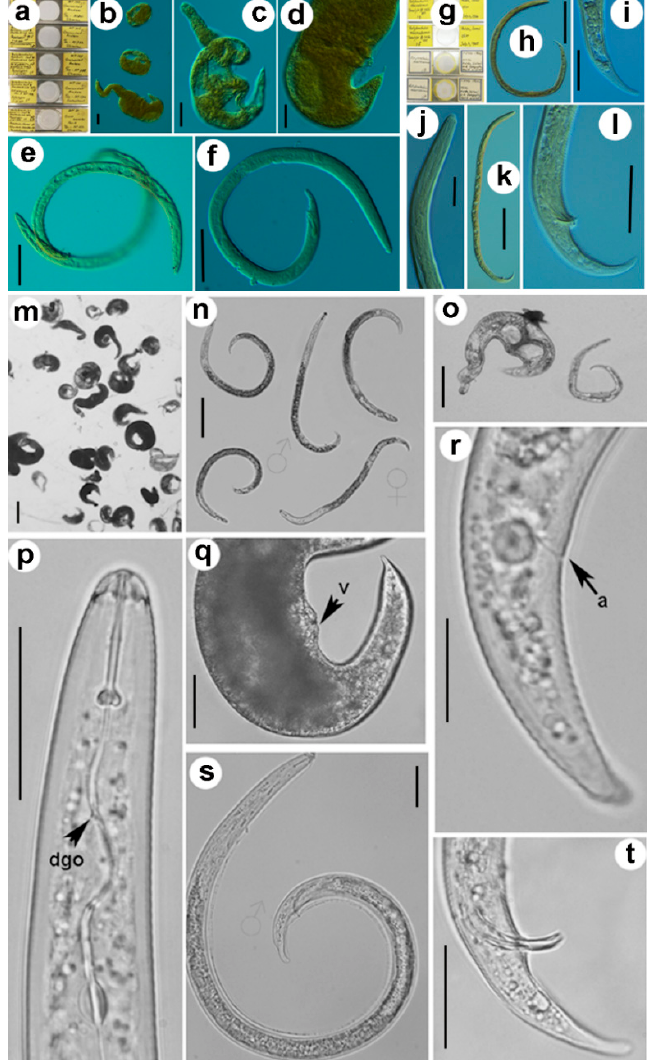
Figure 1. Comparative morphology among paratype specimens of Rotylenchulus borealis from the Netherlands ( a – f ), paratype specimens of Rotylenchulus macrosoma from Israel ( g – l ), and a population of Rotylenchulus macrosoma from Hungary ( m – t ). ( a , g ) slides deposited in Wageningen Nematode Collection (WANECO) and United States Department of Agriculture (USDA) nematode collections; ( b – d , m , o , q ) mature females; ( e , h – j , n , p , r ) immature females; ( f , k , l , n , s , t ) = males. Abbreviations: a = anus; dgo = dorsal gland opening; V = vulva. Scale bars: ( b – d , h , k , m – o ) 100 μ m; ( e , f ) 50 μ m; ( i , j , l , p , q , s , t ) 20 μ m; ( r ) 10 μ m.